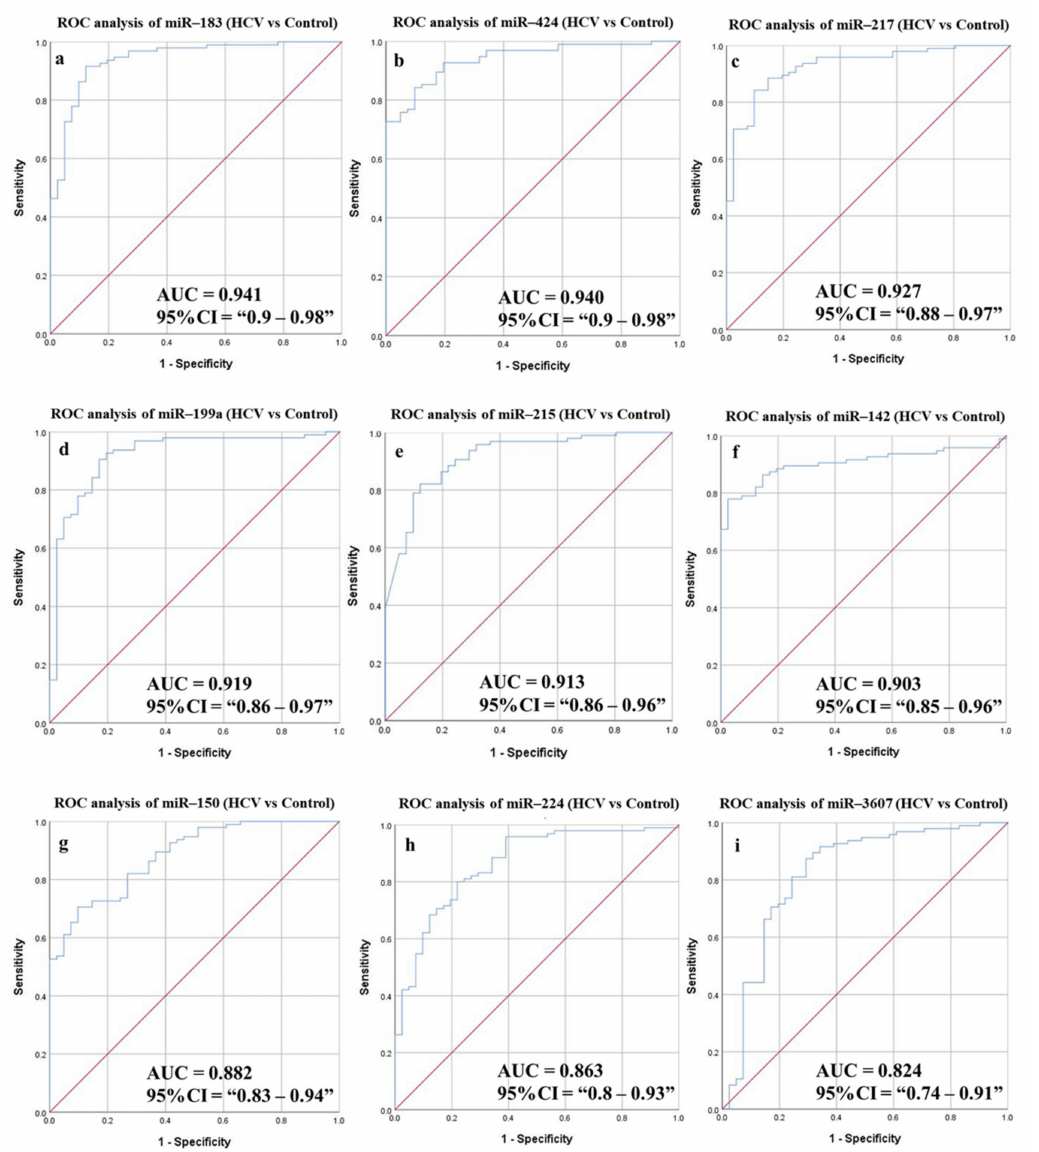
Figure 7. ROC curves and AUC for the DE-miRNAs to differentiate between HCV patients and healthy individuals. The diagnostic potential and AUC of nine DE-miRNAs [( a ) miR-183 ( b ) miR-424 ( c ) miR-217 ( d ) miR-199a ( e ) miR-215 ( f ) miR-142 ( g ) miR-150 ( h ) miR-224 and ( i ) miR-3607] were calculated. (DE: Differentially expressed, HCC: Hepatocellular carcinoma, ROC: Receiver operating